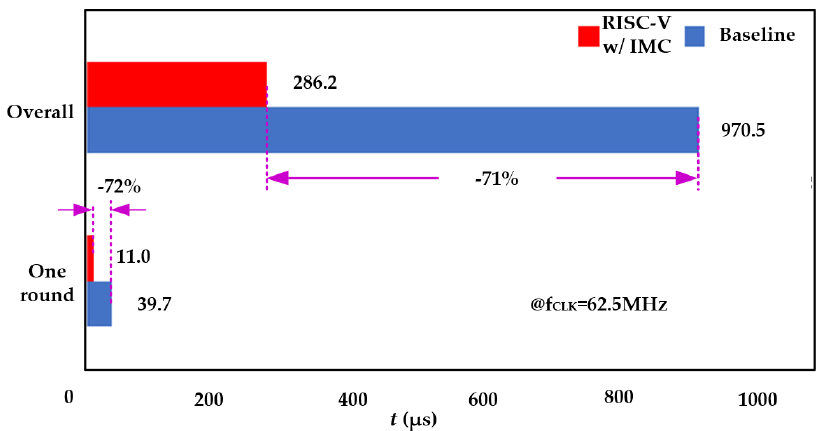
Figure 8. Comparison of processing time for the Keccak algorithm.